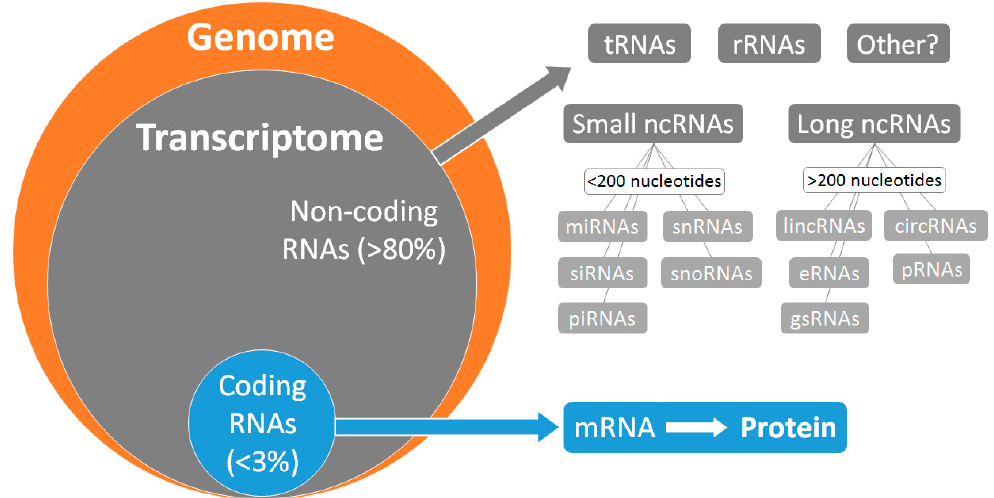
Figure 1. Coding and non-coding RNAs in the human genome. tRNAs, transfert RNAs; rRNAs, ribosomal RNAs; ncRNAs, noncoding RNAs; miRNAs, microRNAs; siRNAs, small-interfering RNAs; snRNAs, small nuclear RNAs; snoRNAs, small nucleolar RNAs; piRNAs, piwi-interacting RNAs; linRNAs, long intergenic RNAs; eRNAs, extracellular RNAs; gsRNAs, germline small RNAs; circRNAs, circular RNAs; pRNAs, promoter-associated RNAs; mRNA, messenger RNA.